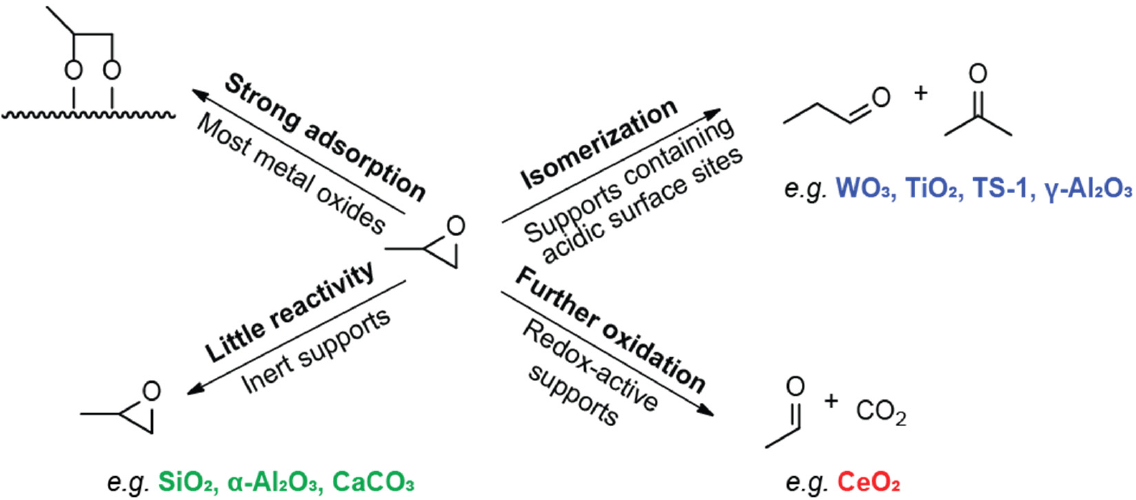
Figure 7. Stacked bed experiments where different support materials exposed to a gas feed contain- ing PO. ( a ) Total selectivity, ( b ) selectivity towards gaseous products. Conditions: 75 mg of Au/TS- 1 catalyst, 150 mg of support material, 10,000 mL/g support /h flow of 10% of each C 3 H 6 , O 2 and H 2 in He at 200 °C, the selectivity was the average between 2–3 h of testing